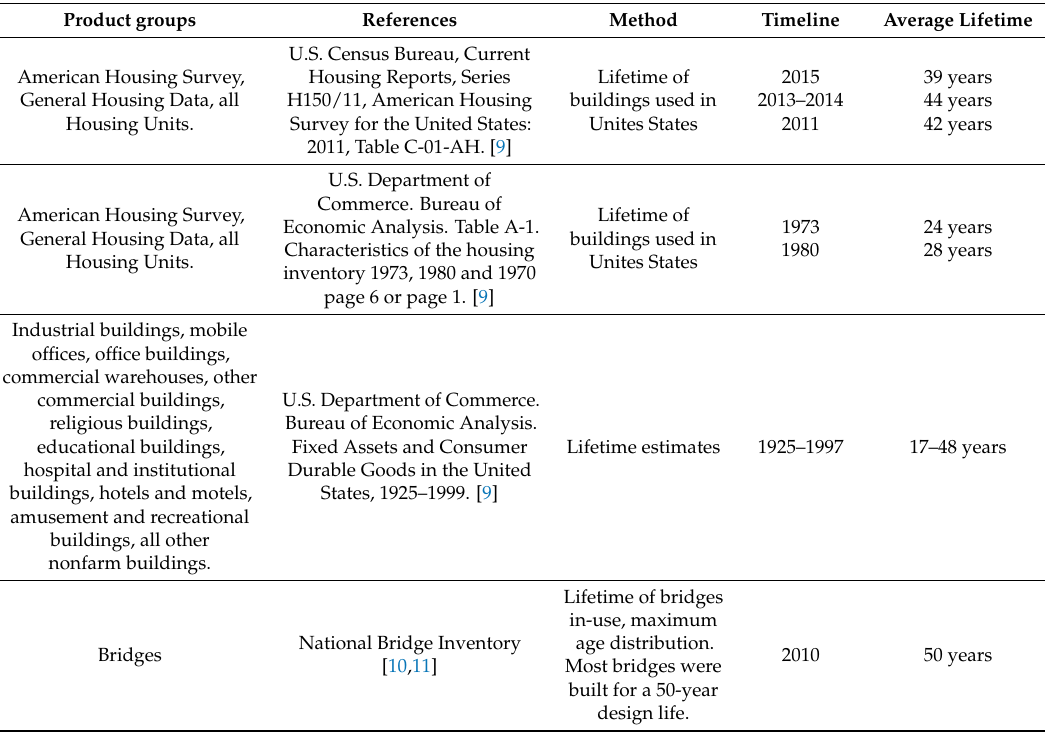
Table A1. Average lifetime per unit in the construction sector in the United States.